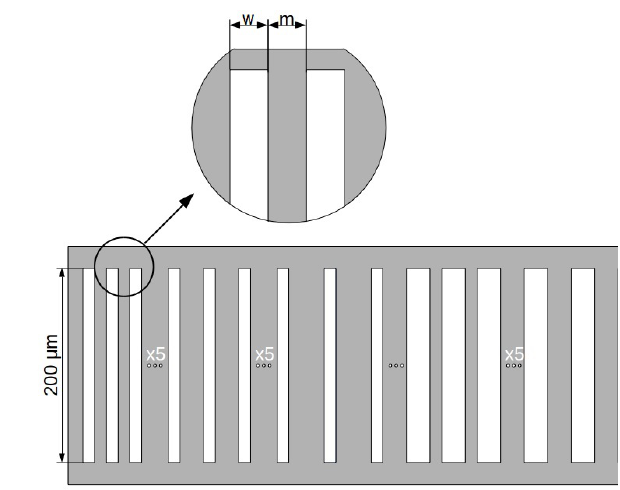
Figure 2. Configuration of the dielectric mask ( m ) and open windows ( w